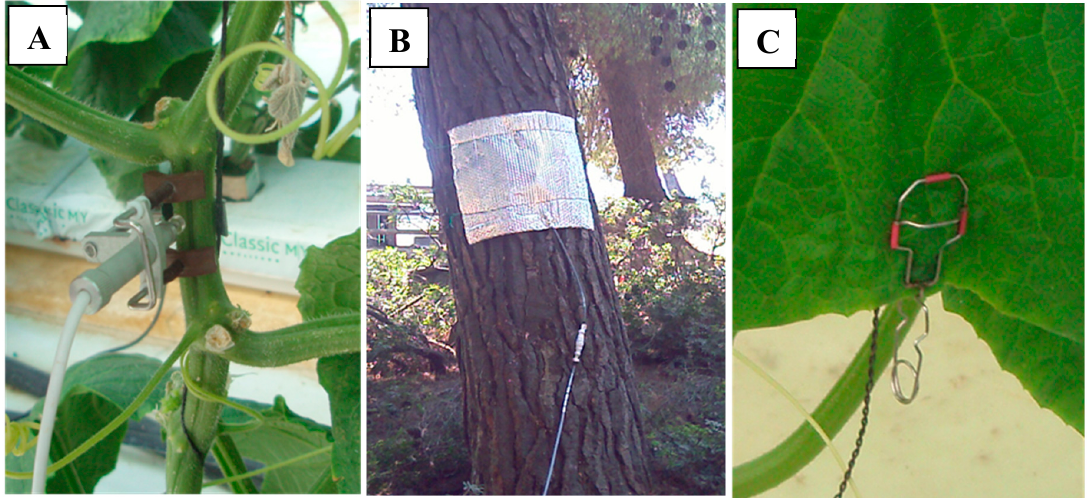
Figure 6. Plan-sensing devices; stem micro-variation ( A ); sap flow (( B ); source: ScientAct S.A., Thessaloniki); leaf temperature ( C ).